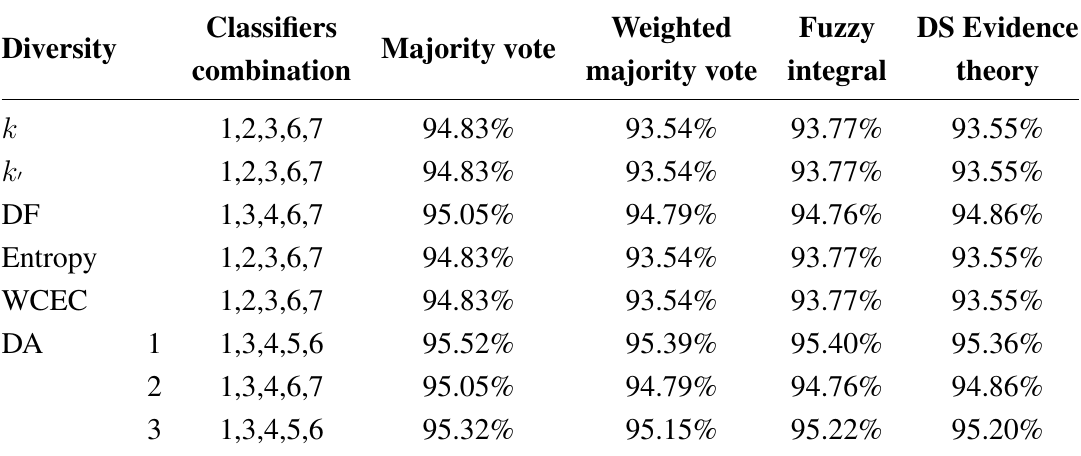
Table 7. The optimum combination selected by diversity